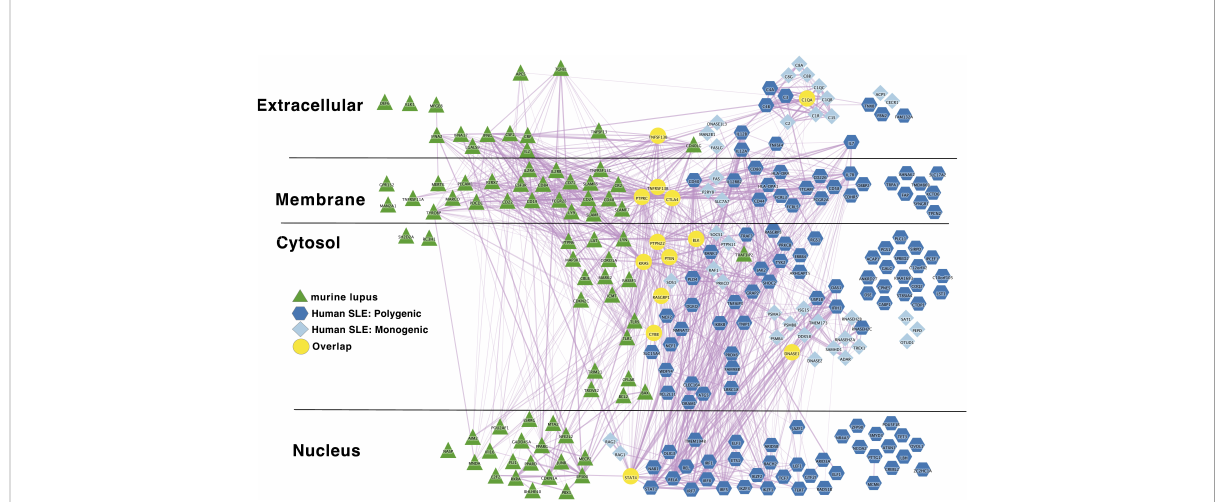
FIGURE 4 Murine Lupus risk genes connect to Polygenic Human SLE risk genes at the periphery of the core network in a manner similar to the monogenic risk SLE network; Light blue diamond – Monogenic human SLE gene; dark blue hexagon – Polygenic human SLE gene; dark green triangle – murine lupus gene; yellow circles – Overlapping genes. Downloadable/Interactive network diagram can be found at: https://doi.org/10.18119/ N9WC8P.